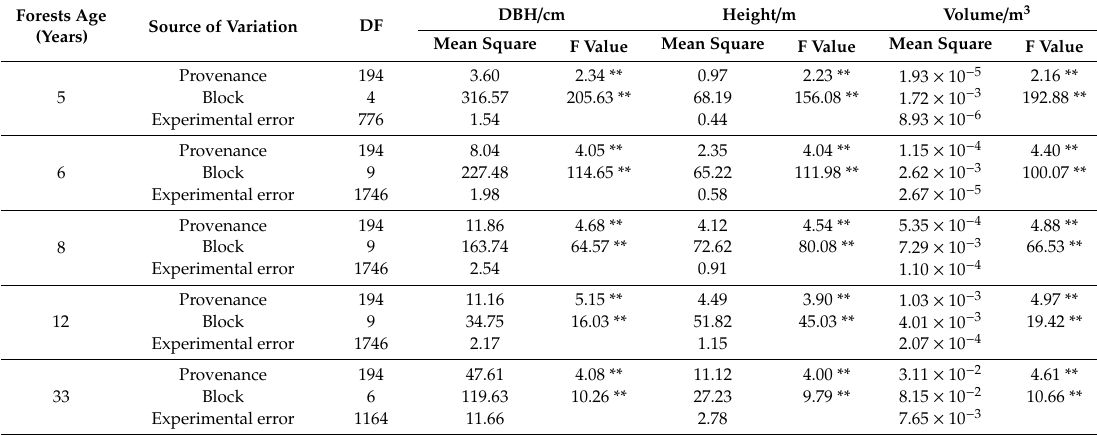
Table 1. Variance analysis of the growth traits of Chinese fir with di ff erentprovenancesat di ff erent ages. ** represents significant at level < 0.01. DBH: diameter at breast hight. DBH / cm Height / m Forests Age DF (Years)